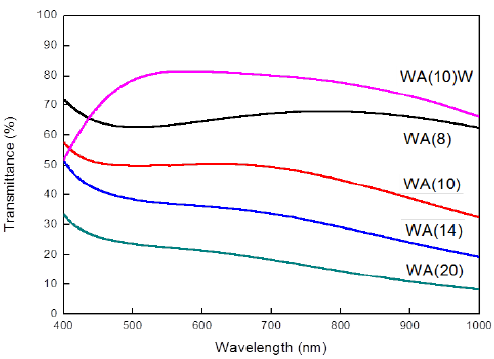
Figure 12. UV-Vis spectrum of WA film at different silver thicknesses as the bottom WO 3 thickness fixed. Table 3. Light transmittance of WA film under various silver thicknesses. Sample